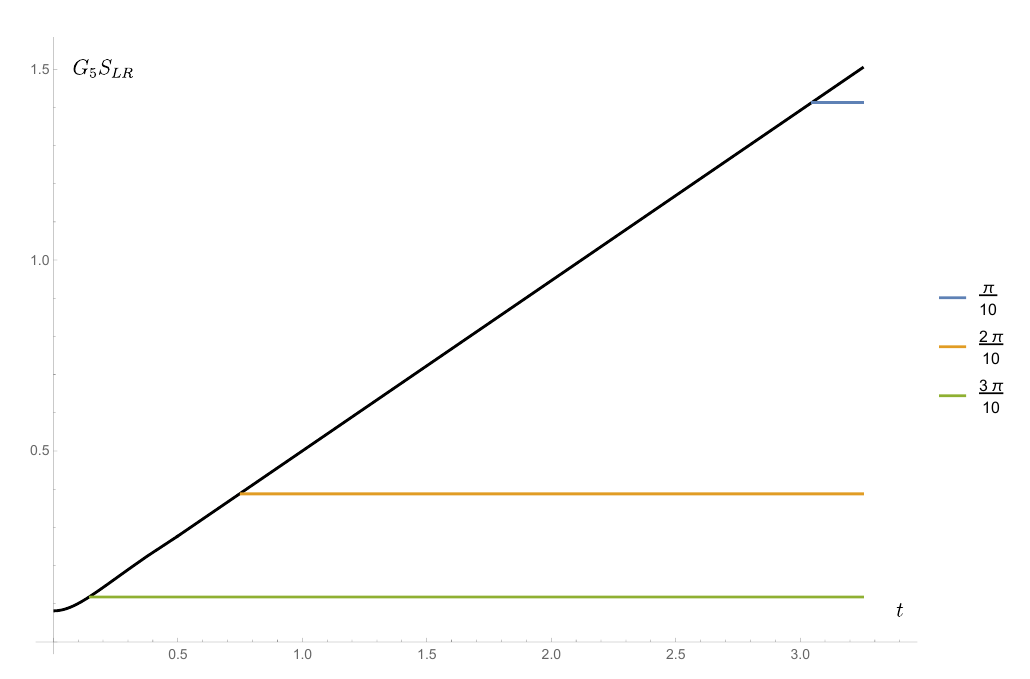
π π π , 2 , 3 starting just below 10 10 10 , the Page time c